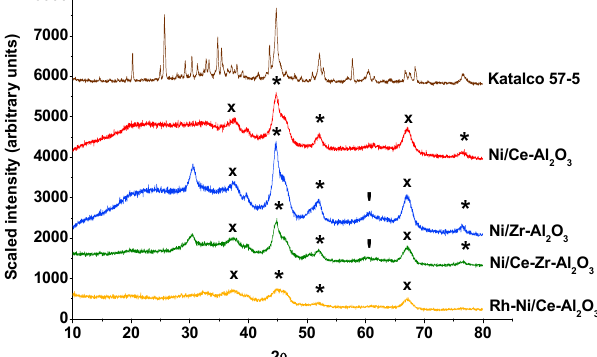
Figure A1. XRD patterns for reduced catalysts: (*) Ni 0 , (x) CeO 2 , and (’) ZrO 2 .